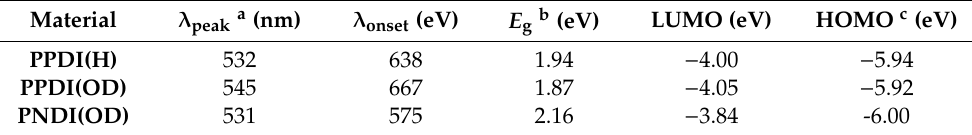
Figure 1. Normalized UV–vis spectra of these polymers in solution ( a ) and as film ( b ). Table 2. Summarized opto-electronic properties of the